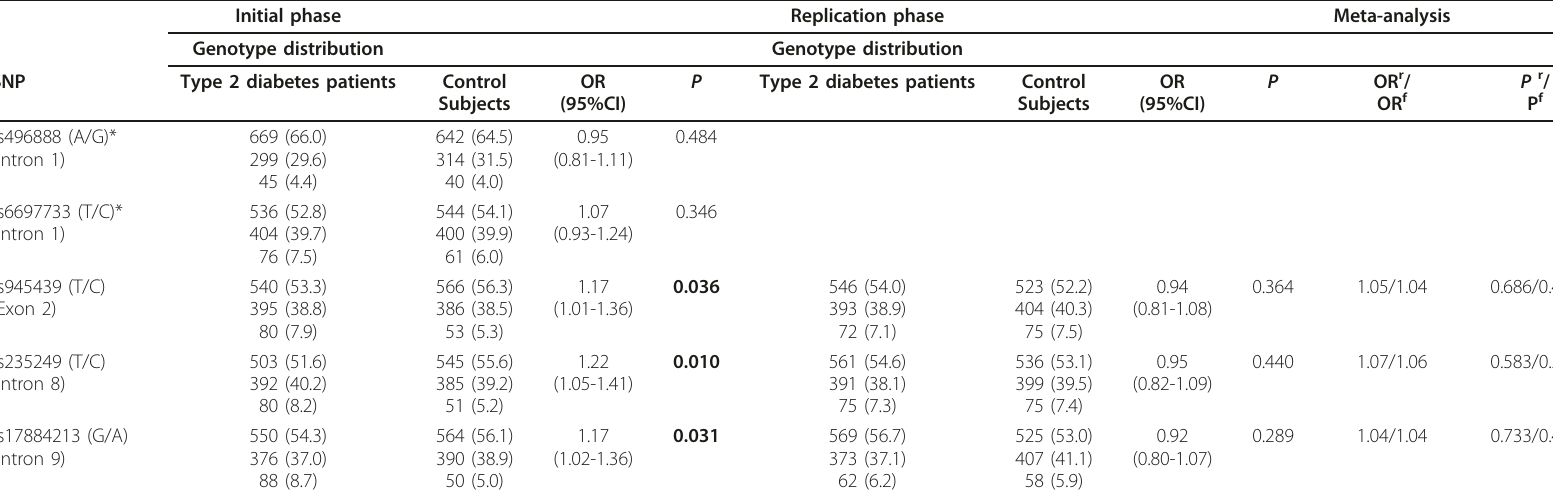
Table 2 Association analysis of TNFRSF1B SNPs with type 2 diabetes in Indo-European population from North